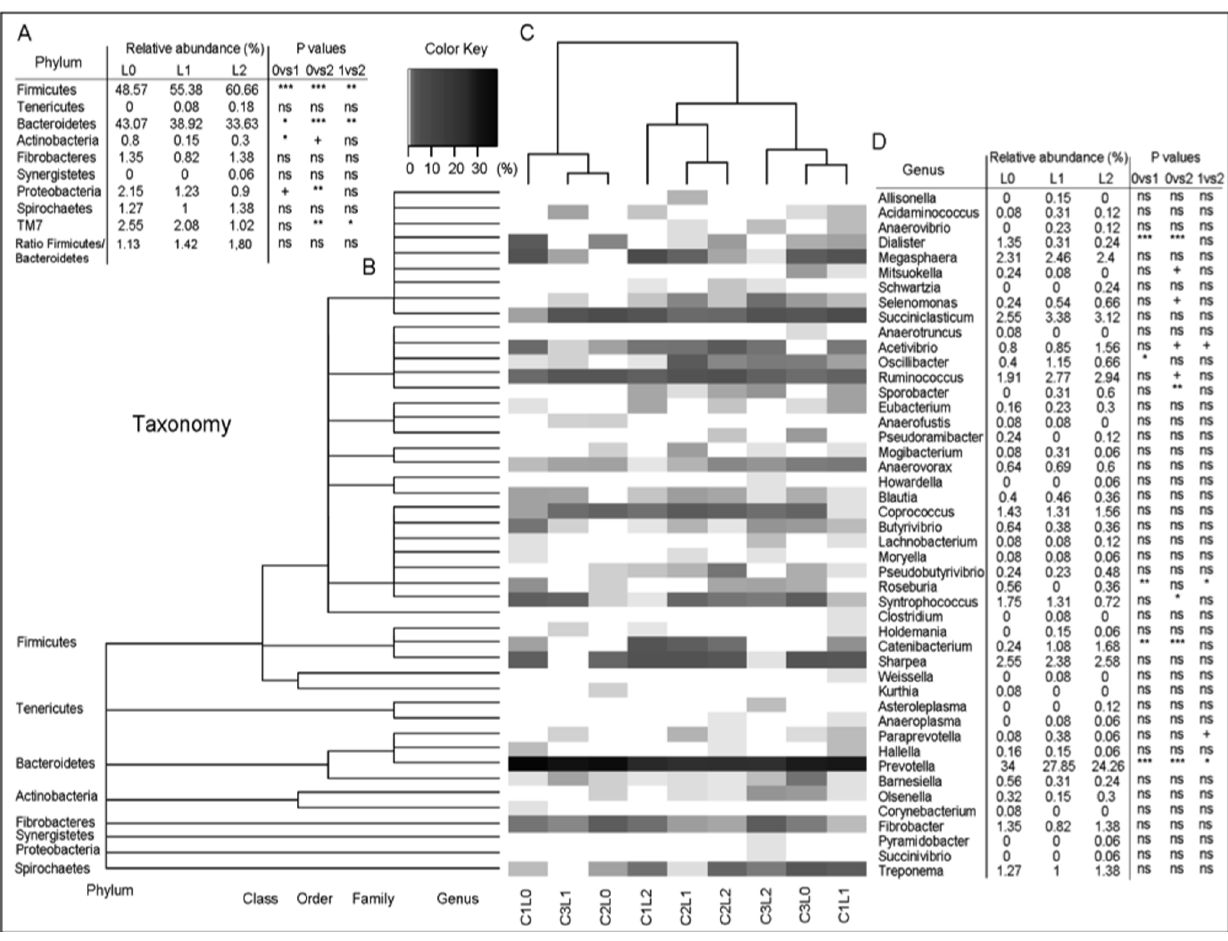
Figure 4. Heatmap of the distribution of the relative abundance of the genera detected with the 454 method. A: Relative abundance of the phyla detected and statistical analysis for treatments. B: Taxonomic classification of the genera. C: Morista-Horn cluster of the relative abundance of the genera. D: Genera detected and statistical analysis for treatments means (Metastats for the sequence count data and Anova for the ratio Firmicutes/Bacteroidetes). L0=Control; L1=0.5 g/d of yeast; L2=5 g/d of yeast; 0vs1=Control vs 0.5 g/d of yeast; 0vs2=Control vs 5 g/d of yeast; 1vs2=0.5 g/d of yeast vs 5 g/d of yeast. P value: ns= . 0.1, + = , 0.1; *= , 0.05; **= , 0.01; ***= , 0.001.